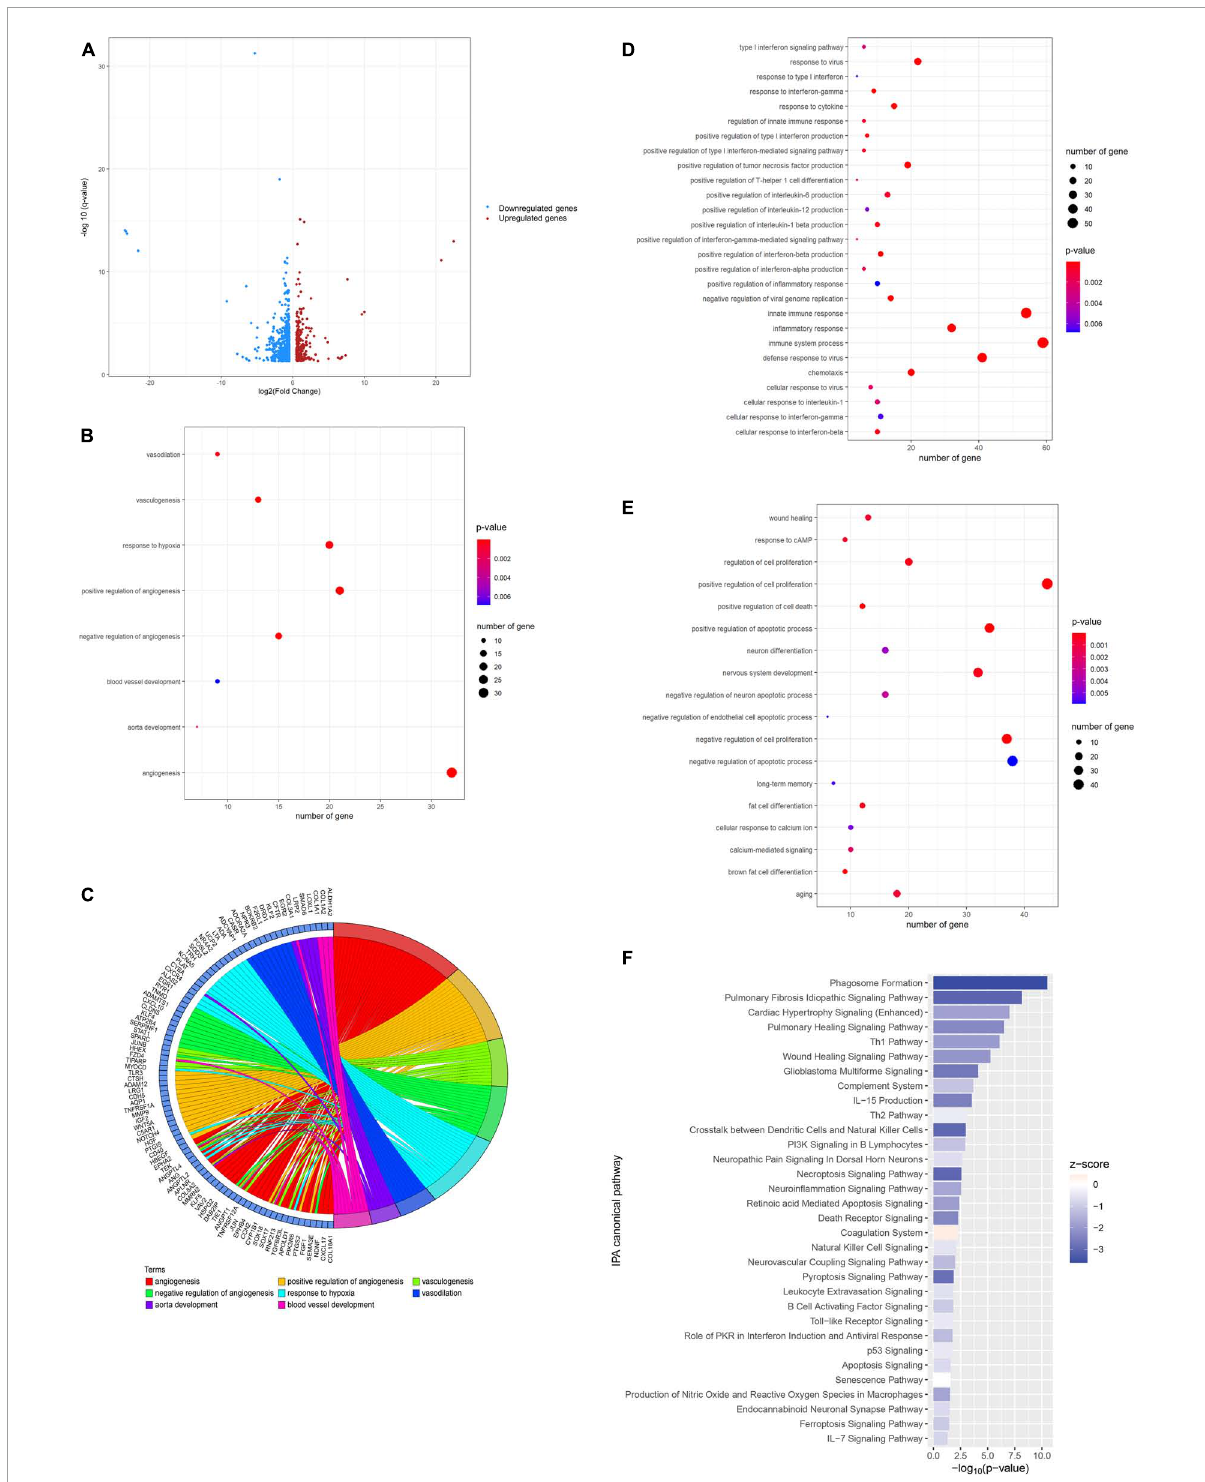
FIGURE2 Laminarin regulated blood vessel development and promoted the brain function. (A) Volcano plot showing the differential gene expression in normal brain caused by laminarin treatment. Blue dots represent downregulated genes and red dots represent upregulated genes. (B) Circos plot showing the involvement of laminarin-targeted gene cluster in blood vessel-related processes. Gene ontology enrichment analysis highlighted the involvement of laminarin in biological processes related to (C) blood circulation and oxygen supply, (D) immune and inflammatory responses, and (E) brain functions. The size of the bubble represents the number of genes and the color of bubble represents the significance of the biological process. (F) Canonical Ingenuity Pathway Analysis (IPA) showed the inhibition of immune response and cell death processes in the normal brain. Negative z -score represents the inhibition of